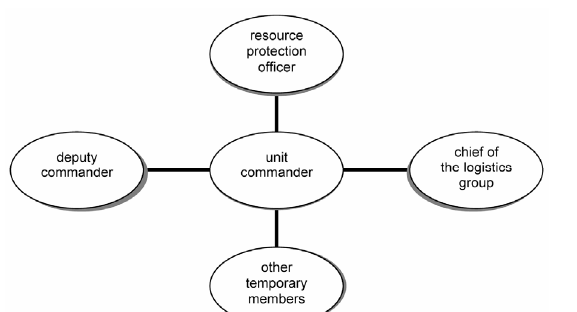
Figure 1 – Organizational structure of the expert team of a battalion-division Рис . 1 – Организационная структура экспертной группы батальона - дивизиона Слика 1 – Организацијска структура стручног тима батаљона –